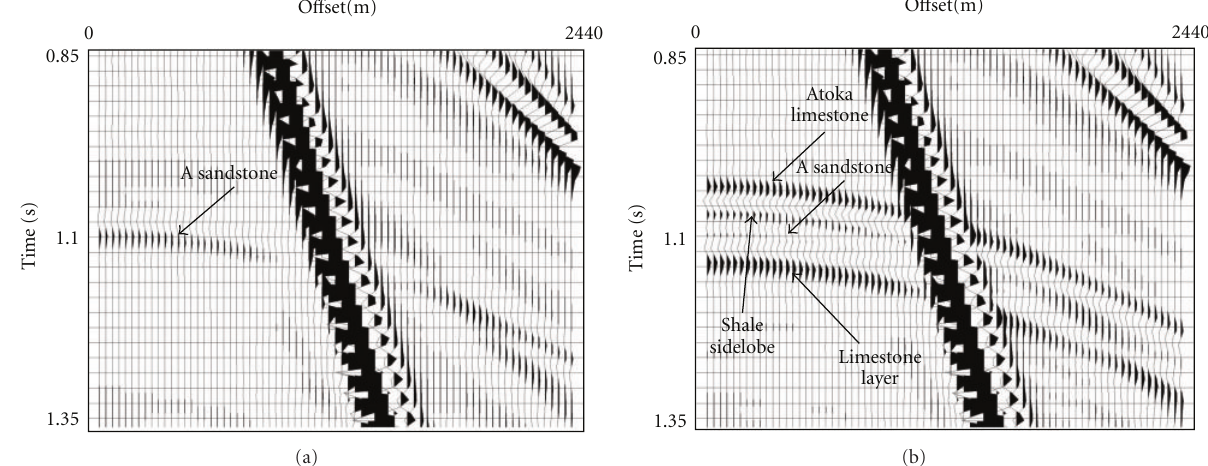
Figure 12: (a) P-wave gather for Model 1a shows a Class II AVO anomaly at the top of Morrow A sandstone where a small peak changes into trough with o ff set. (b) The P-wave gather for Model 3a shows that the peak at the top of Morrow A sandstone is interfered with the side lobe of Morrow shale and bottom limestone layer. This gives a peak doublet at near o ff sets which changes to a single peak at far o ff sets.